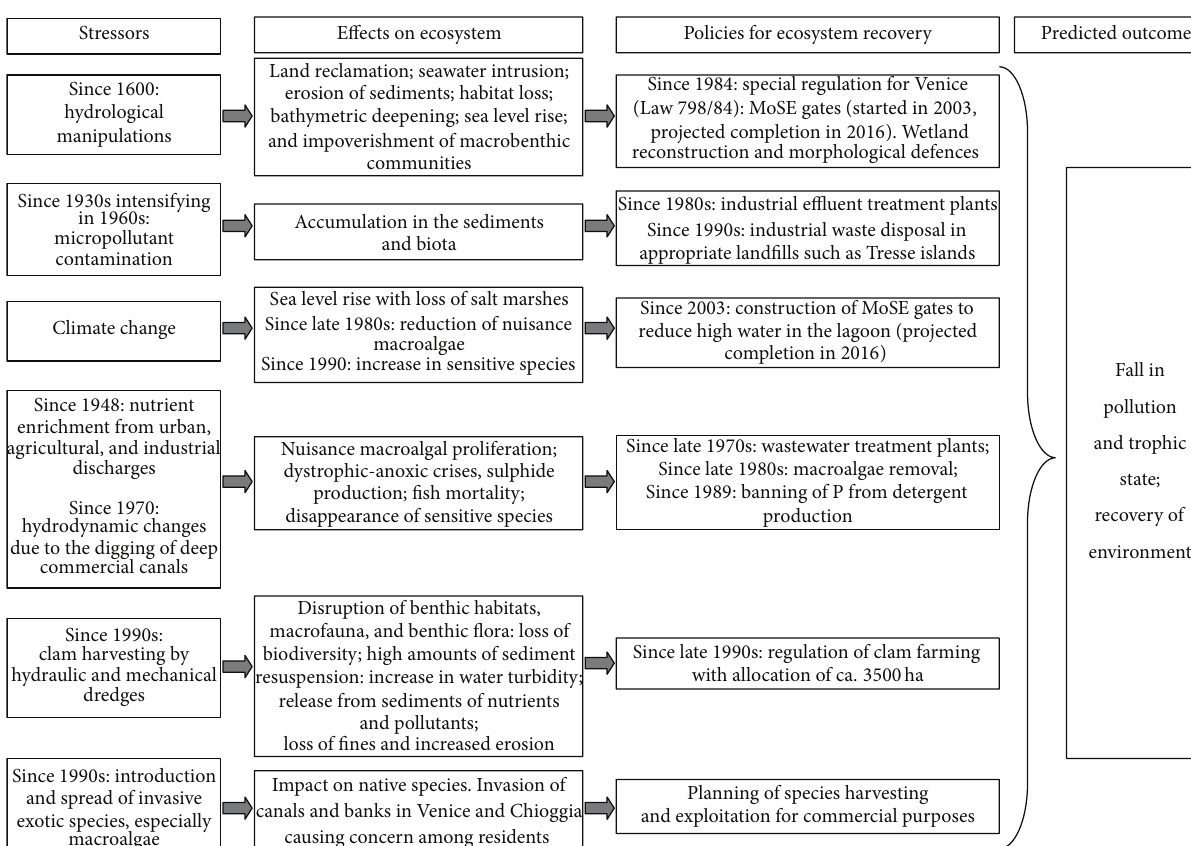
Figure 1: Scheme of main stressors (categories in accordance with [4]) affecting Venice Lagoon, effects on ecosystem, policies adopted, and predicted